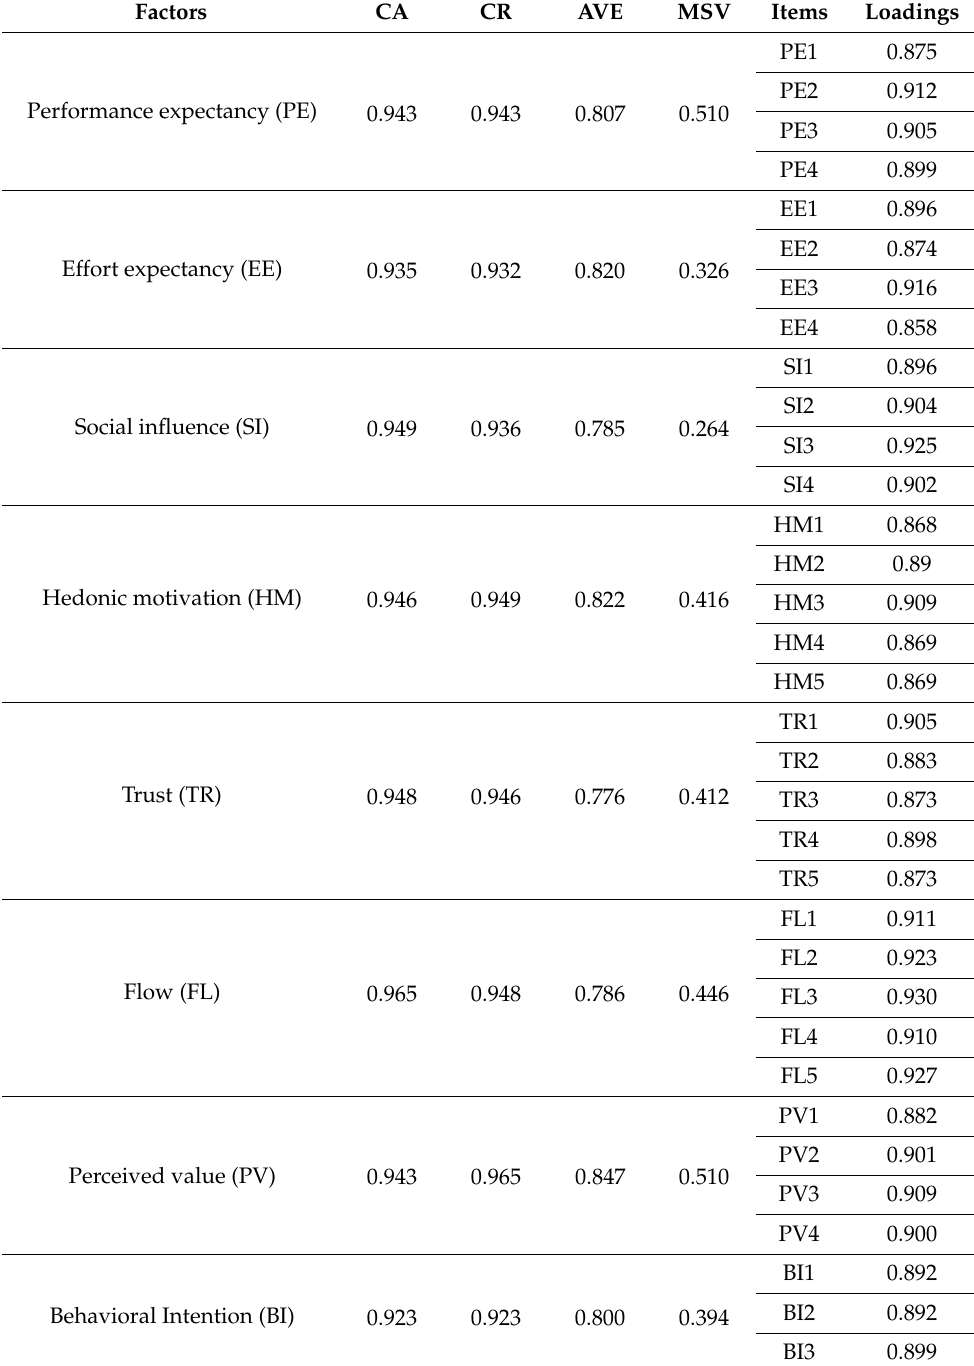
Table 3. Latent constructs’ CA, CR, AVE, MSV, and items’ factor